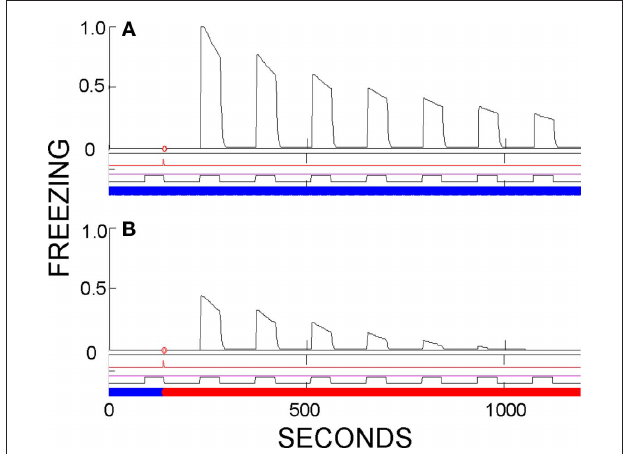
FigurE 8 | Evidence of partial context-specificity of cue conditioning. CS evokes greater fear in the training context than a novel context if conditioning was established by a single weak US. (A) Testing in training context. (B) Testing in a different context. Summation tests would have disclosed subthreshold contextual fear in the training context, but not enough to account for the greater freezing seen in the training